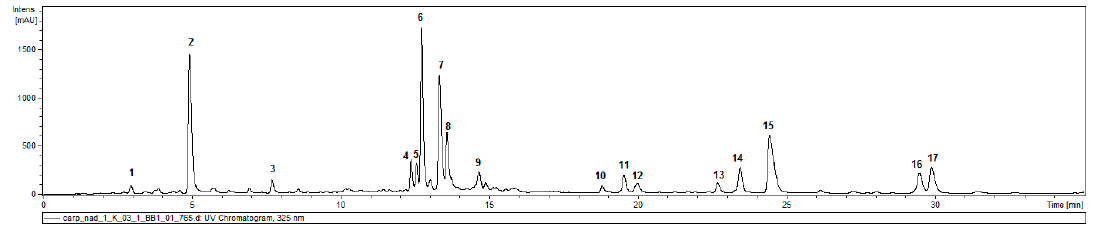
Figure 1. An HPLC-UV chromatogram of Carpesium divaricatum aerial part extract (10 mg/mL, 2 μ L injected) acquired at 325 nm.